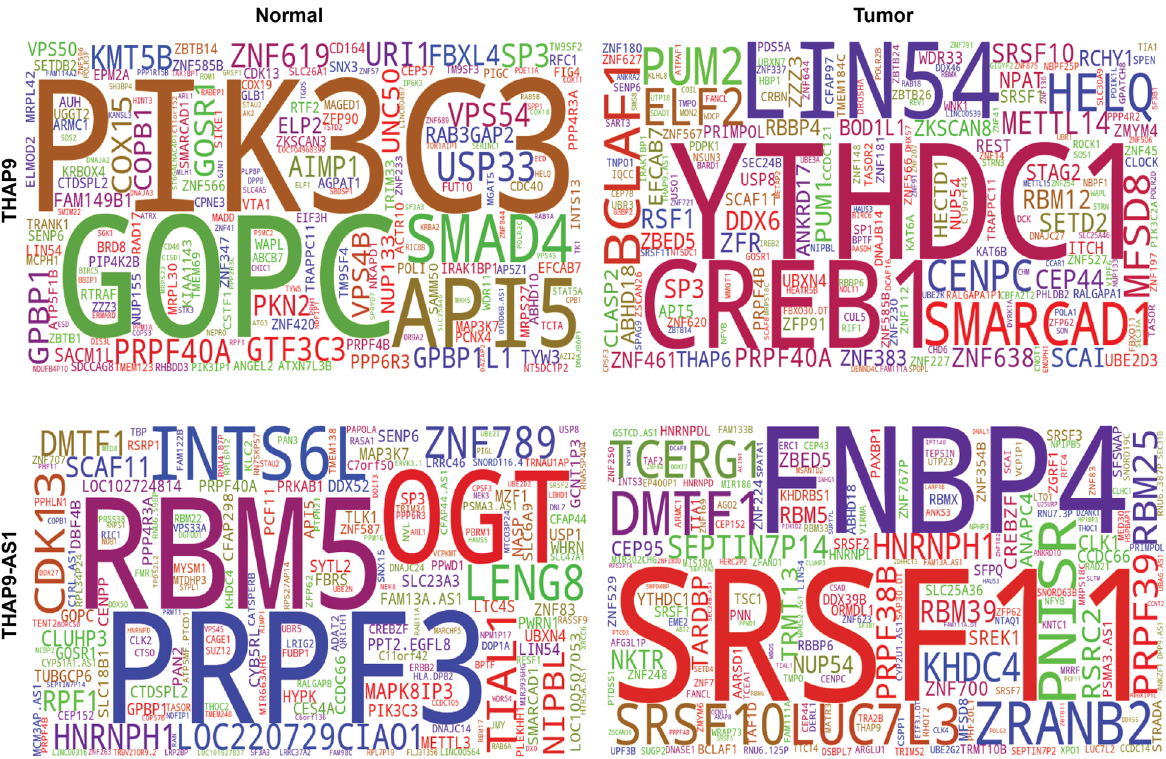
Figure 9. Consensus of genes co-expressed with THAP9 and THAP9-AS1. Word cloud of top 20 genes frequently co-expressed with: (1st row) THAP9 in all combined normal ( top-left ) vs. tumor ( top-right ) samples; (2nd row) THAP9-AS1 in combined normal (bottom-left) vs. tumor ( bottom-right ) samples. The co-expressing genes were identified using the WGCNA Bioconductor package and plotted using the Wordcloud python package. The height of a word is directly proportional to the frequency of co-expression with THAP9. The top 20 co-expressed genes are plotted only for representation purposes; details of the full gene cluster associated with THAP9 and THAP9-AS1 in each cancer type (normal and tumor tissues separately) are available in Supplementary Tables S8, S9 and